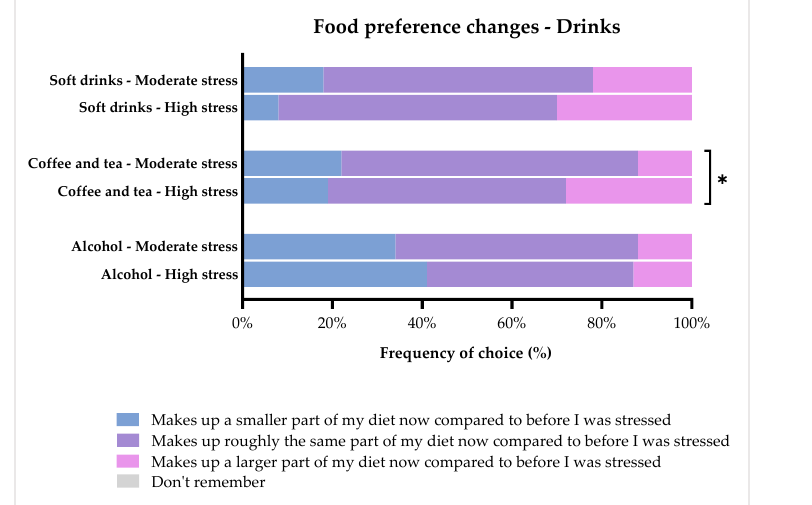
Figure 8. ( a ) Meal types. Diet composition reported by current state as compared to before being ill with stress. Results are shown for the two groups based on the results of the PSS-10: ‘Moderate stress’ ( n = 116) and ‘High stress’ ( n = 74). Stars indicate level of significance of p -values. *: p < 0.001. ( b ) Food product types. Diet composition reported by current state as compared to before being ill with stress. Results are shown for the two groups based on the results of the PSS-10: ‘Moderate stress’ ( n = 116) and ‘High stress’ ( n = 74). Stars indicate level of significance of p -values. *: p < 0.001. ( c ) Drinks. Diet composition reported by current state as compared to before being ill with stress. Results are shown for the two groups based on the results of the PSS-10: ‘Moderate stress’ ( n = 116) and ‘High stress’ ( n = 74). Stars indicate level of significance of p -values. *: p < 0.05, **: p < 0.01.